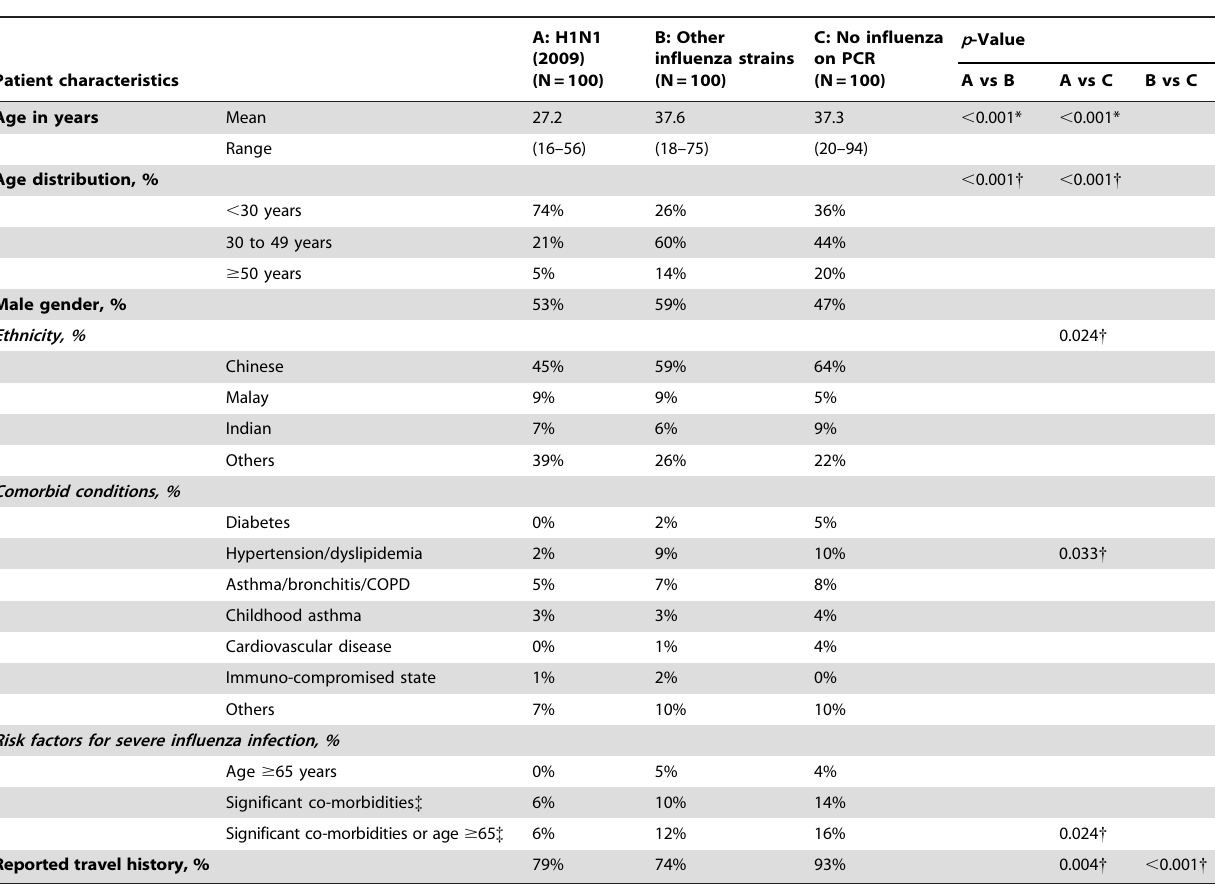
Table 1. Demographics, co-morbidities, and history of